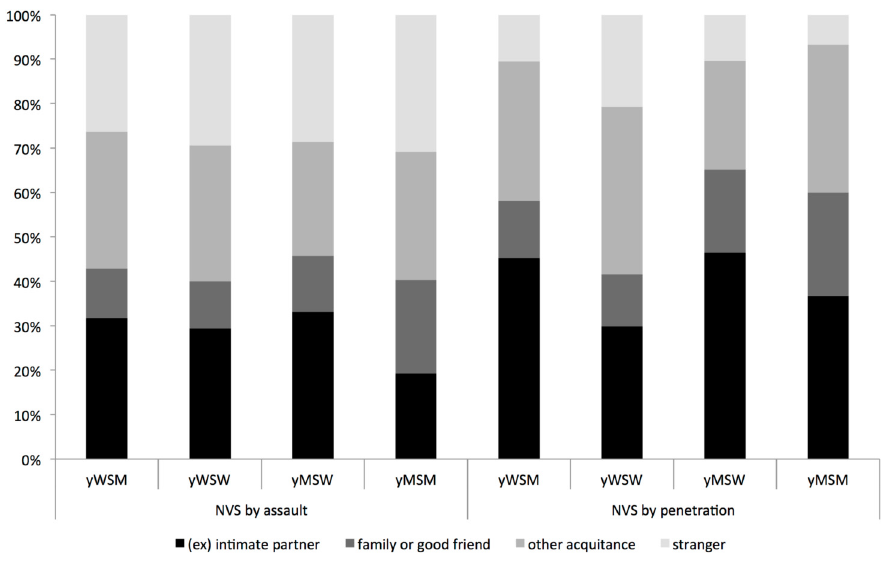
Fig 1. Perpetrator of NVS by assault and NVS by penetration in most recent